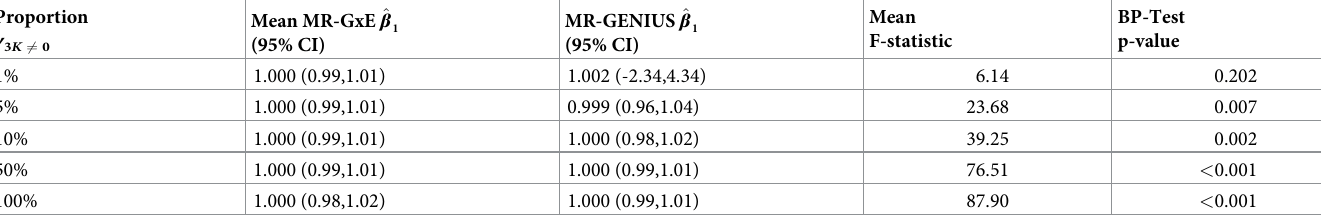
Table 1. Simulated results using differing proportions of non-zero interaction covariates (simulation